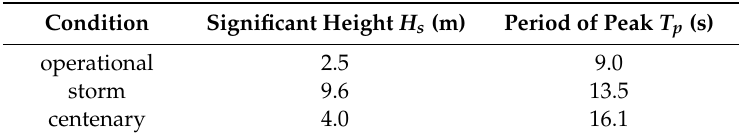
Table 5. Irregular wave condition parameters in the full scale using the International Ship and O ff shore Structures Congress (ISSC) spectrum.